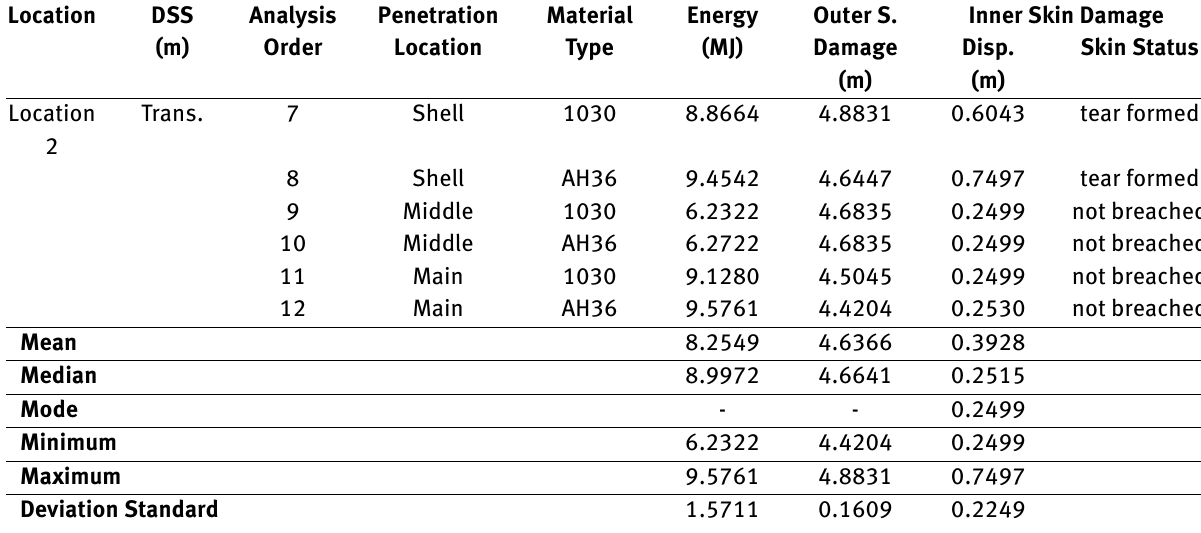
Table A.2: Statistical analysis on Location